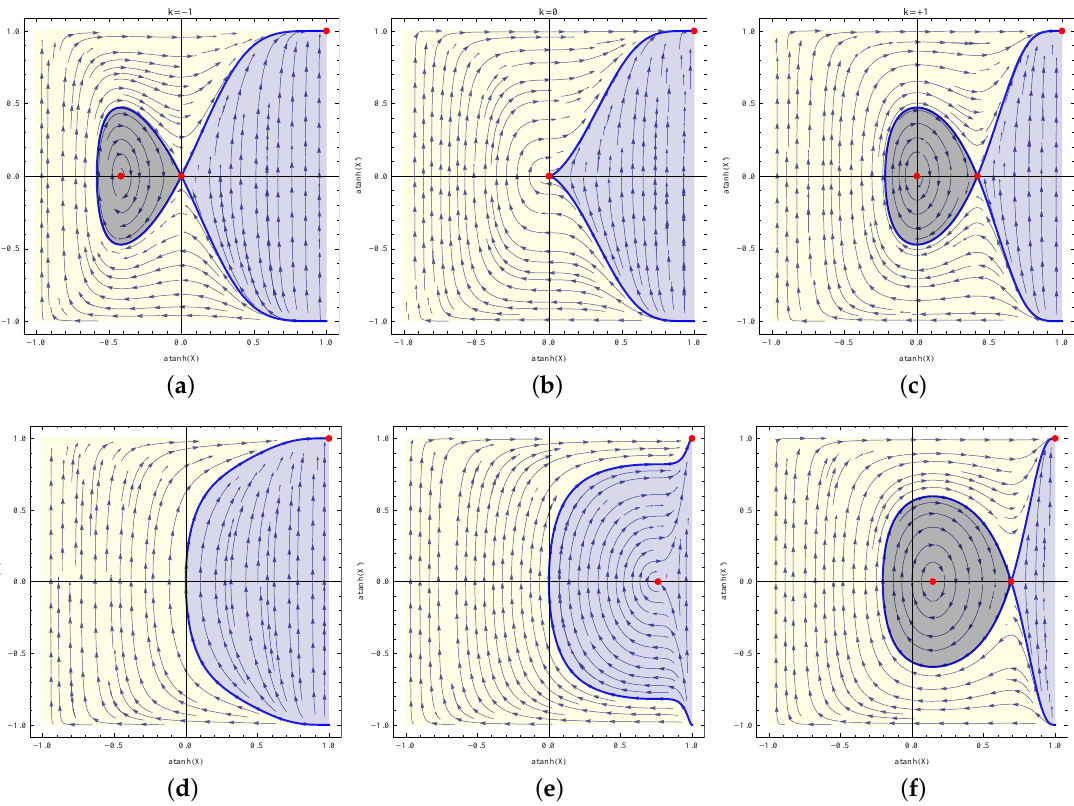
Figure 3. Behaviour of X and X (cid:48) for a scalar-tensor theory with a potential λ 0 . The upper three phase diagrams, ( a – c ), respectively, correspond to the k = − 1,0, + 1 cases for vacuum and stiff fluid. The lower three phase diagrams, ( d – f ), depict the qualitative behaviour of radiation models, with: ( d ) When M λ 0 > 1 ( e ) When M λ 0 = 1 ( f ) When M = 1/4 and λ 0 =